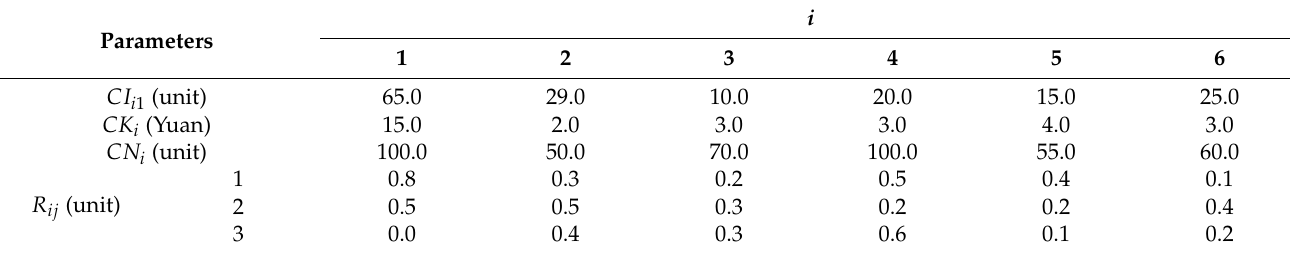
Table A3. Parameters of inventory and raw